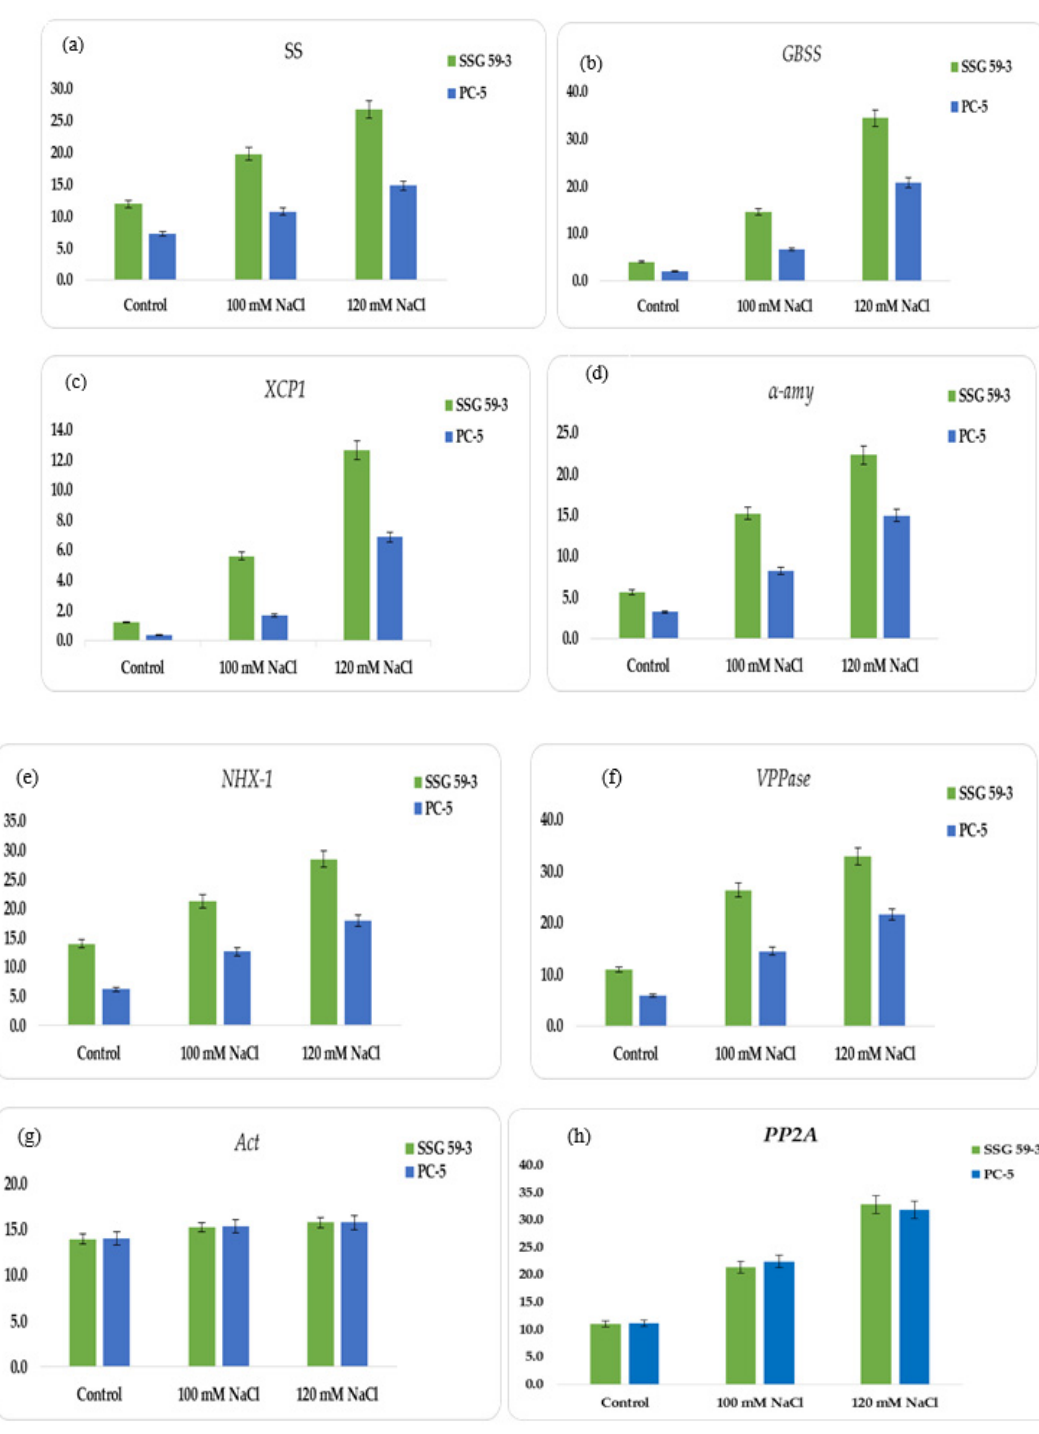
Figure 8. Relative quantification of: ( a ) Sucrose synthase ( SS ), ( b ) granule-bound starch synthase ( GBSS ), ( c ) cysteine protease ( XCP1 ), ( d ) α -amylase synthesis ( α -amy ), ( e ) sodium proton antiporter ( NHX-1 ), ( f ) vacuolar-proton pyrophosphatase ( VPPase-I ), ( g ) actin ( Act ), and ( h ) PP2A .